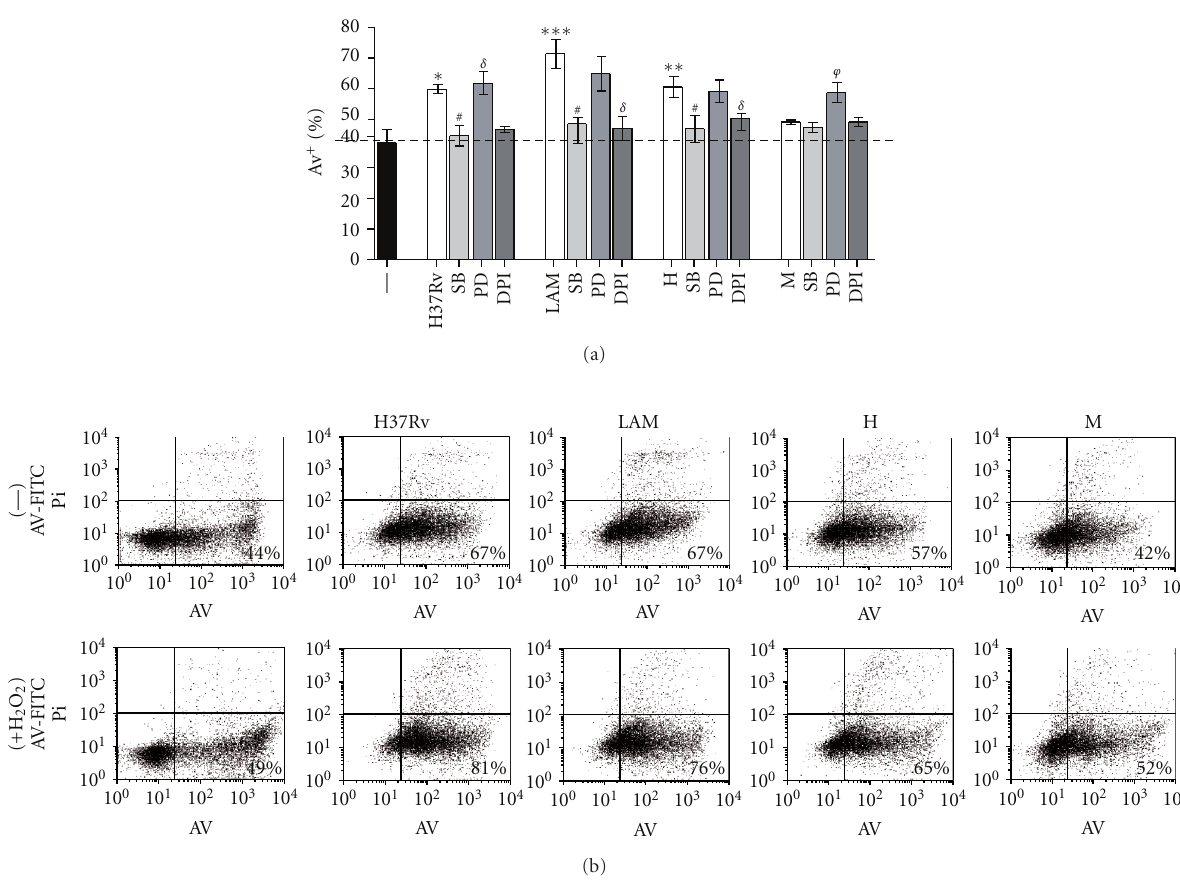
Figure 4: Role of MAP kinases and reactive oxygen species in PMN apoptosis induced by Mtb strains. (a) PMN (3 × 10 6 /mL) were cultured in media alone (control, —) or stimulated with Mtb strains at 1:2 Mtb :PMN ratio for 18h, in the presence or absence of specific inhibitors for p38 and ERK (SB203580 and PD98059, resp.), and an oxidase inhibitor DPI. Thereafter, Annexin V-FITC (AV-FITC) binding was measured by flow cytometry. Results are expressed as media ± SEM ( n = 12). Statistical di ff erences: Control versus LAM: ∗∗∗ P < 0 . 001, control versus H: ∗∗ P < 0 . 01, control versus H37Rv: ∗ P < 0 . 05; H37Rv, LAM and H versus SB: # P < 0 . 01; H37RV, LAM and H versus DPI: σ P < 0 . 001; M versus PD: ϕ P < 0 . 01. (b) PMN were treated with 10mM H 2 O 2 15min before Mtb challenge and thereafter PMN were cultured as described in (a). After 18 h-culture, Annexin V-FITC (AV-FITC) positive PMN was measured by flow cytometry. A representative experiment out of four is